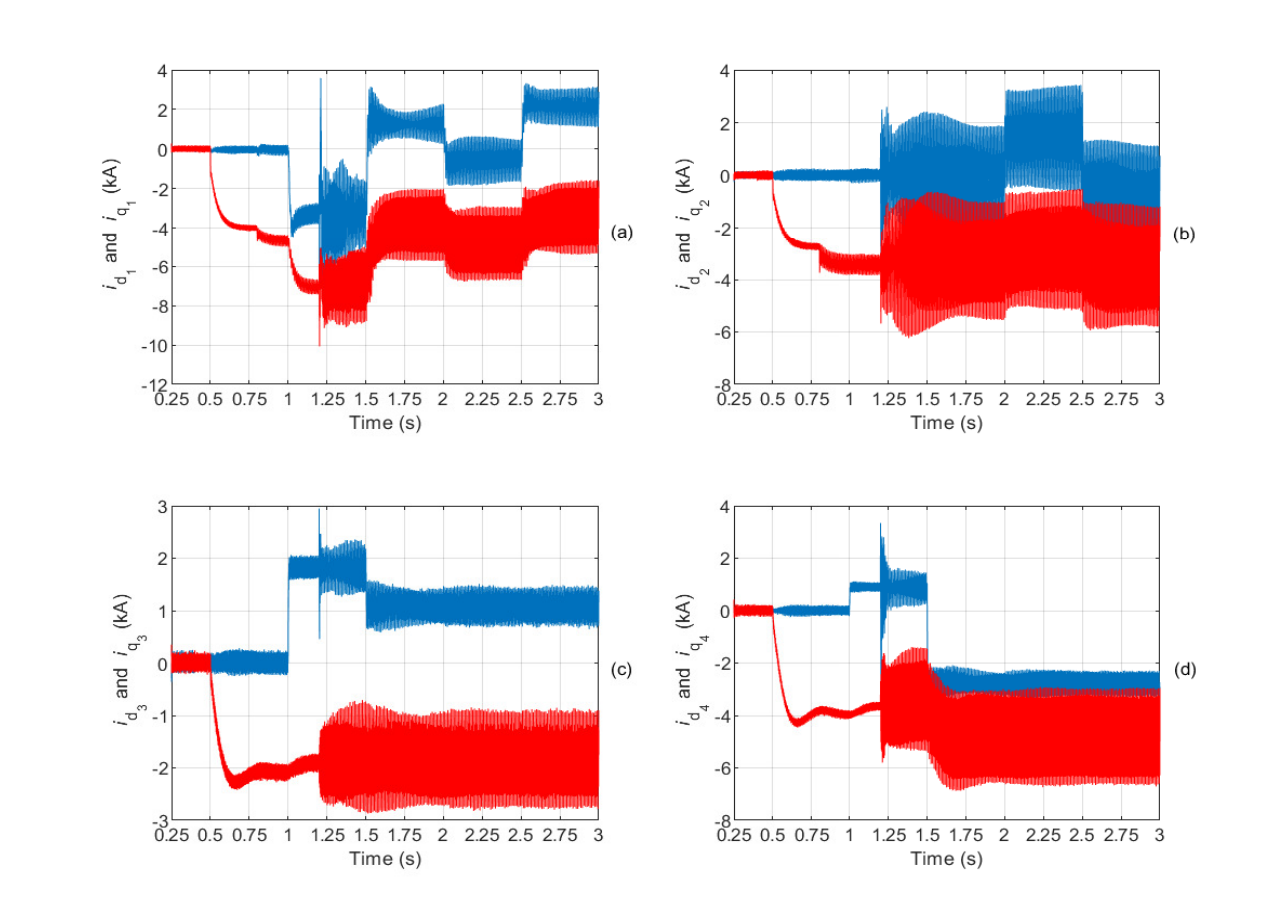
Figure 11. Time responses of the d component (blue color) and q component (red color) of the current through each terminal of the HVDC system: ( a ) i d